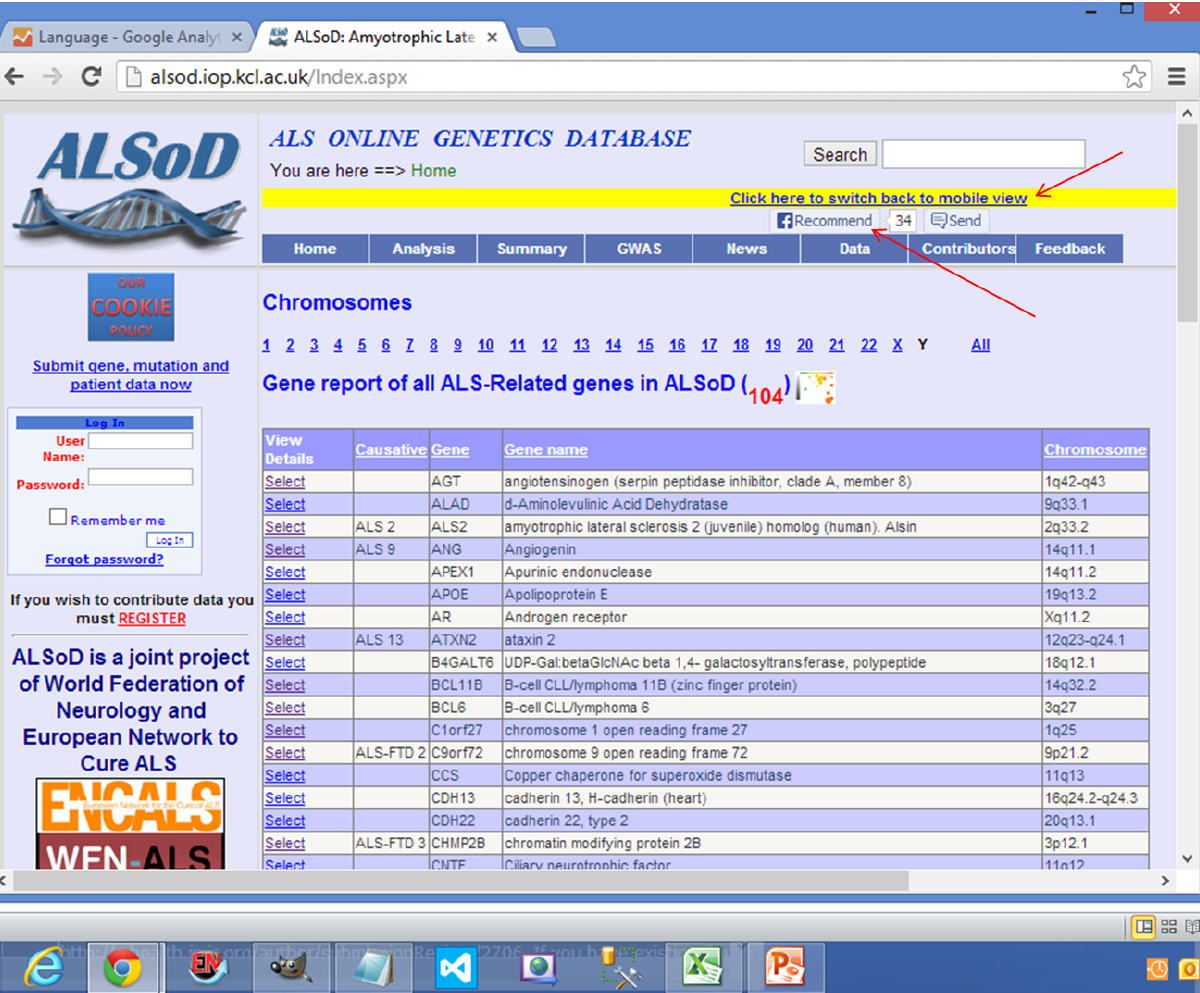
Figure 3. Desktop view creating awareness using Facebook and a